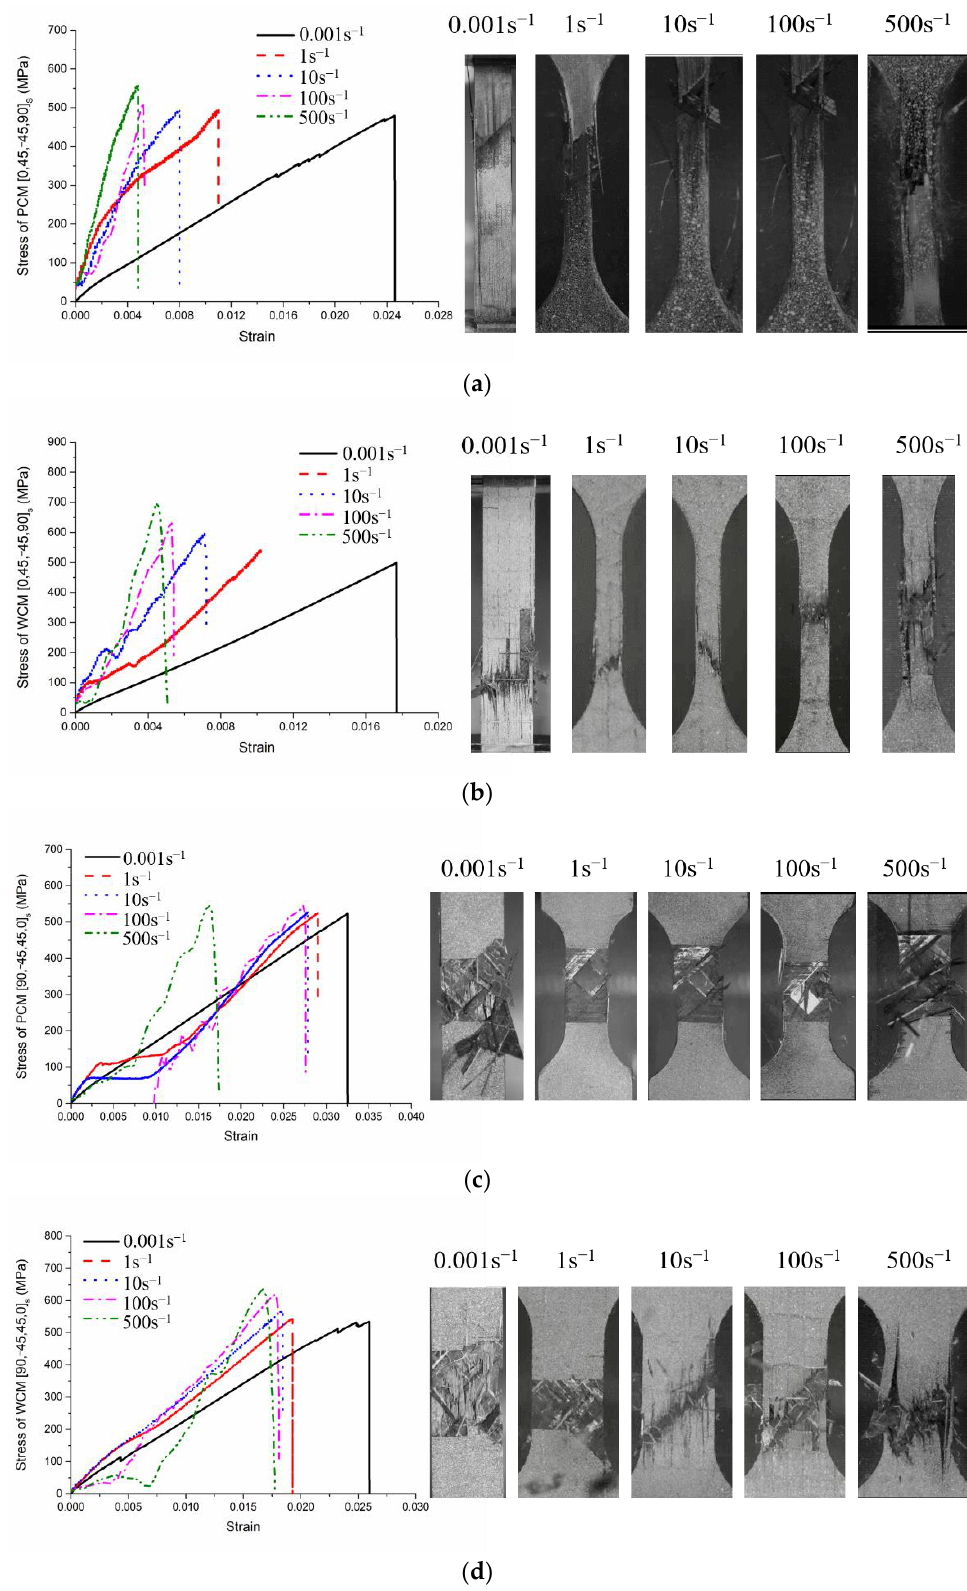
Figure 5. Tensile stress–strain curve and fracture images of typical configurations made using both processes: ( a ) (0/45/−45/90)s made using PCM; ( b ) (0/45/−45/90)s made using WCM; ( c ) (90/−45/45/0)s made using PCM; ( d ) (90/−45/45/0)s made using WCM.